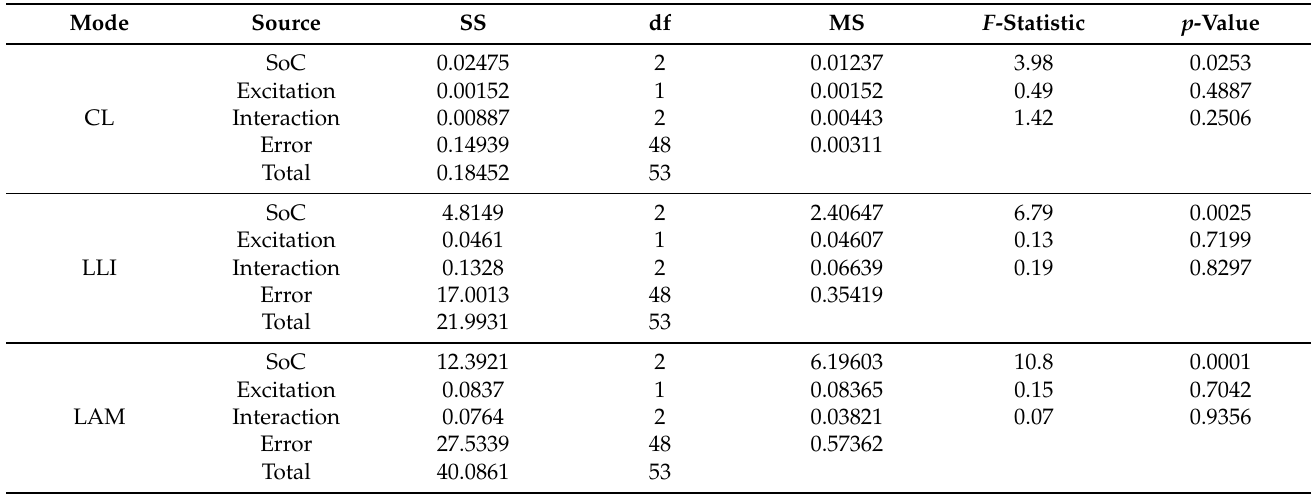
Table 4. The results of two-way analysis of variance under 45 ◦ C@0.5–1 C condition.